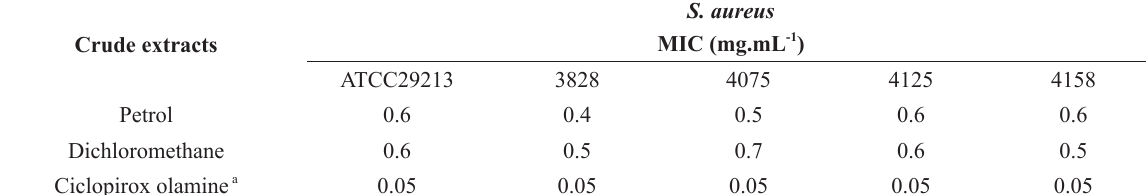
MIC values (mg.mL -1 ) of extracts from Plectrantus orn a tus leaves against Staphylococcus aureus strains.